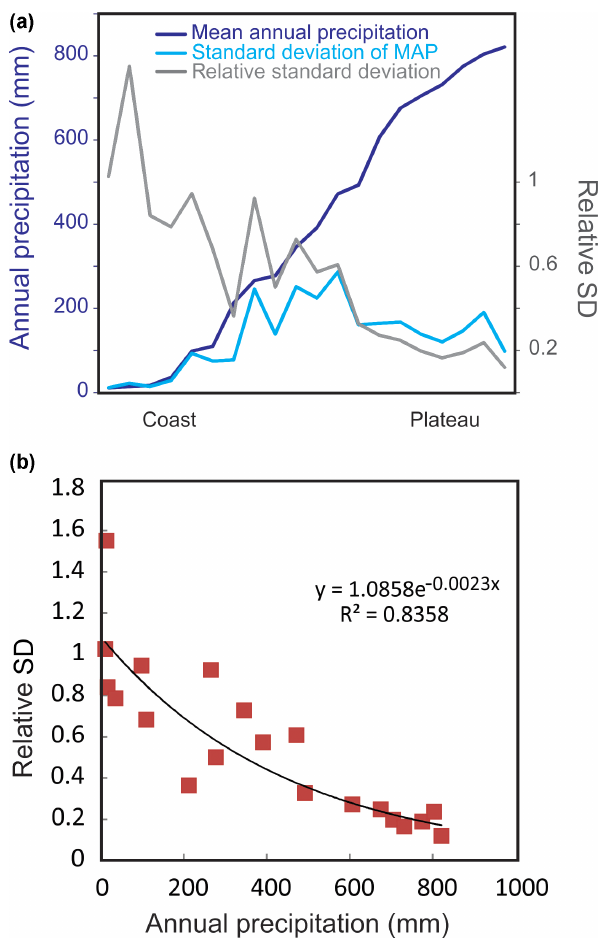
Figure 8. Variation in annual precipitation calculated from 20-year monthly averages (Agteca, 2010). The relative interannual variabil- ity is largest near the coast, where El Niño years bring increased precipitation (a) . The relationship between relative variability and annual precipitation (b) was applied to the soil production and trans- port models and carried through as uncertainty (Figs. 9 and 10).